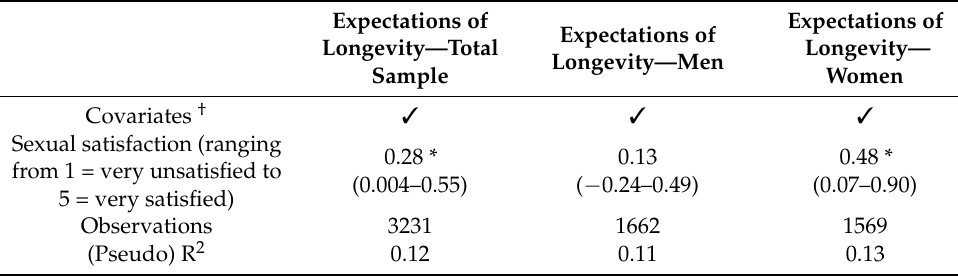
Table 2. Sexual satisfaction and expected longevity. Results of multiple linear regressions (wave